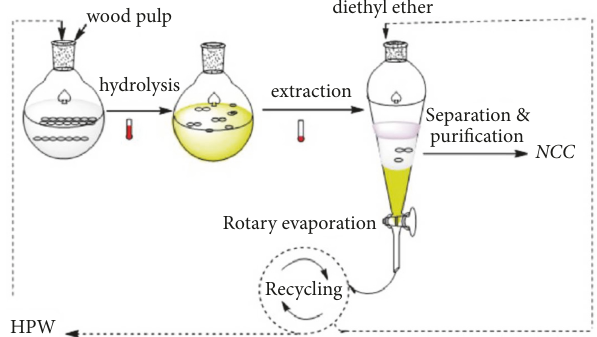
Figure 3: The overall procedure for the manufacture of CNCs by using HPW (HPW: phosphotungstic acid, H 3 PW 12 O 40 )